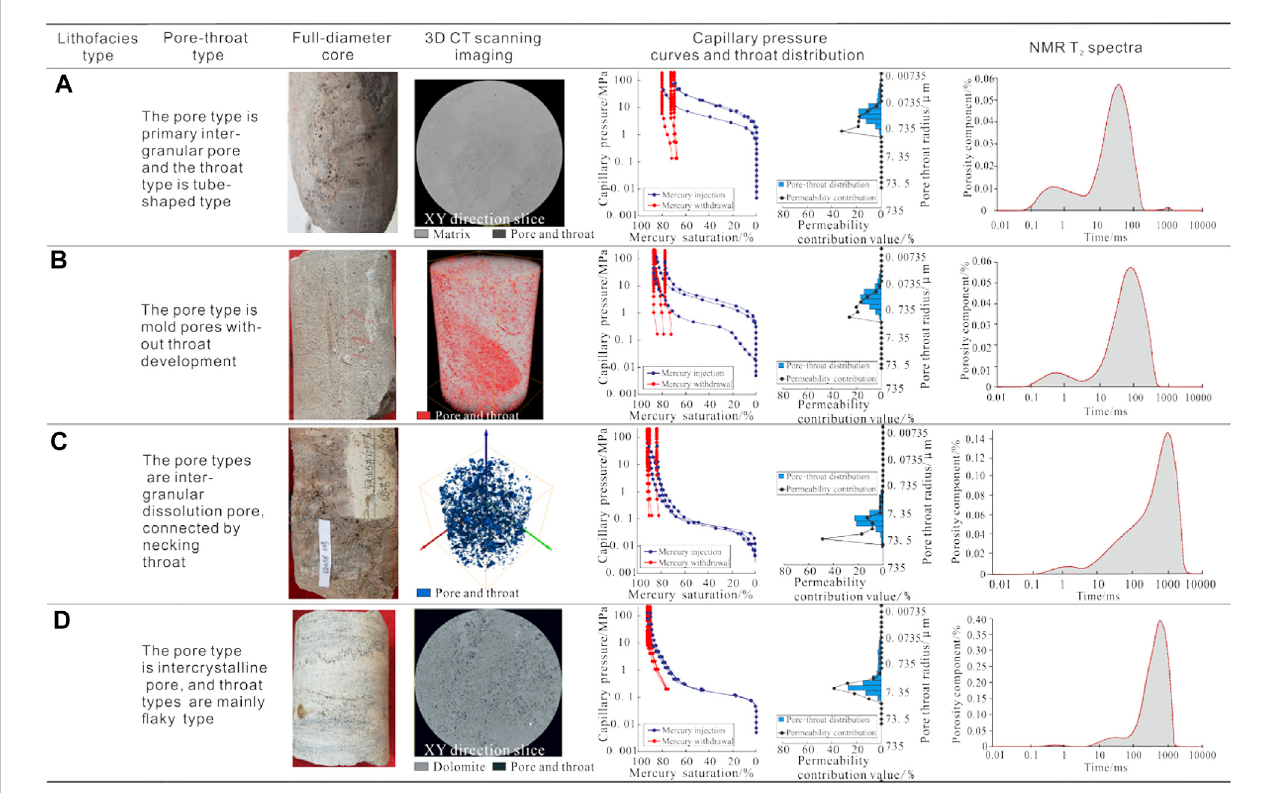
FIGURE 5 Pore-throat structure characteristics of different lithofacies in Feixianguan Formation tight oolitic reservoir.